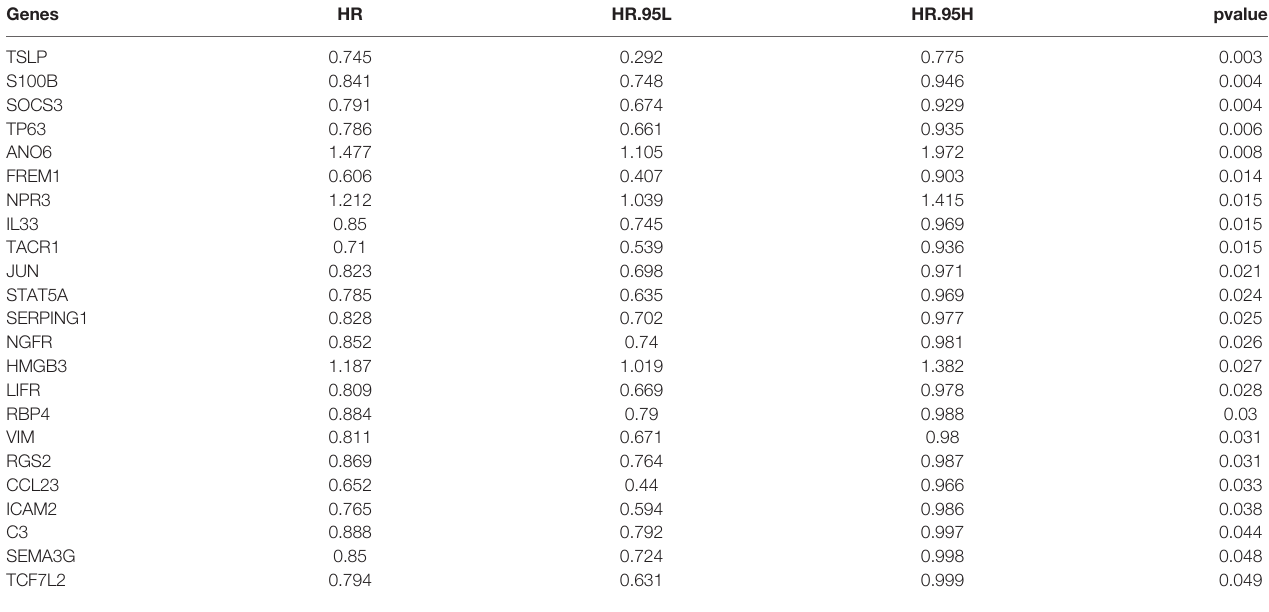
TABLE 1 | Results of univariate Cox proportional risk regression analysis of 196 IRGs (P<0.05). Genes HR